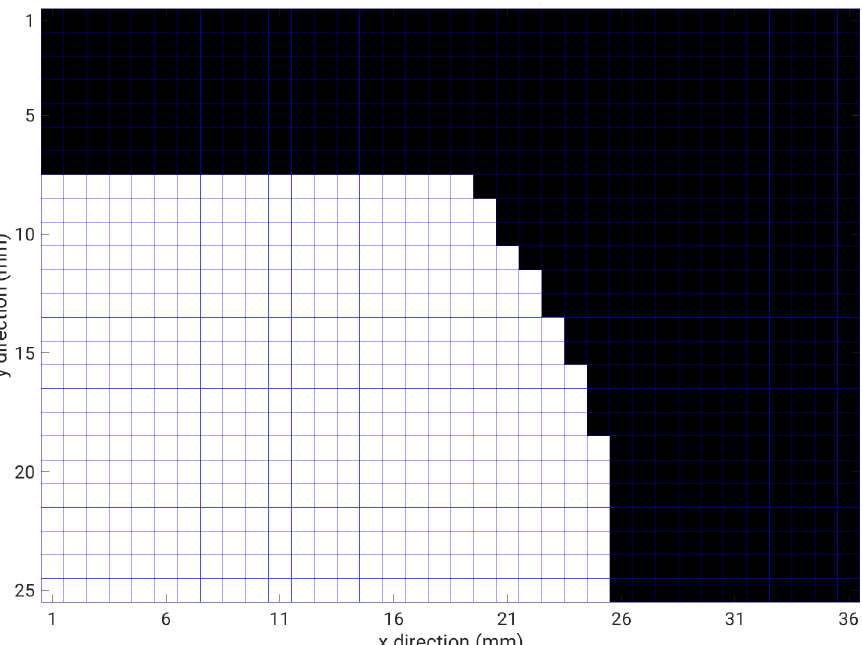
Figure 6. Bitmap representation of the topological space. We represent with a black square (pixel = 1) a portion of space filled with ferromagnetic material, while a white square (pixel = 0) represents an empty portion of space. In this figure, the right mold occupation is